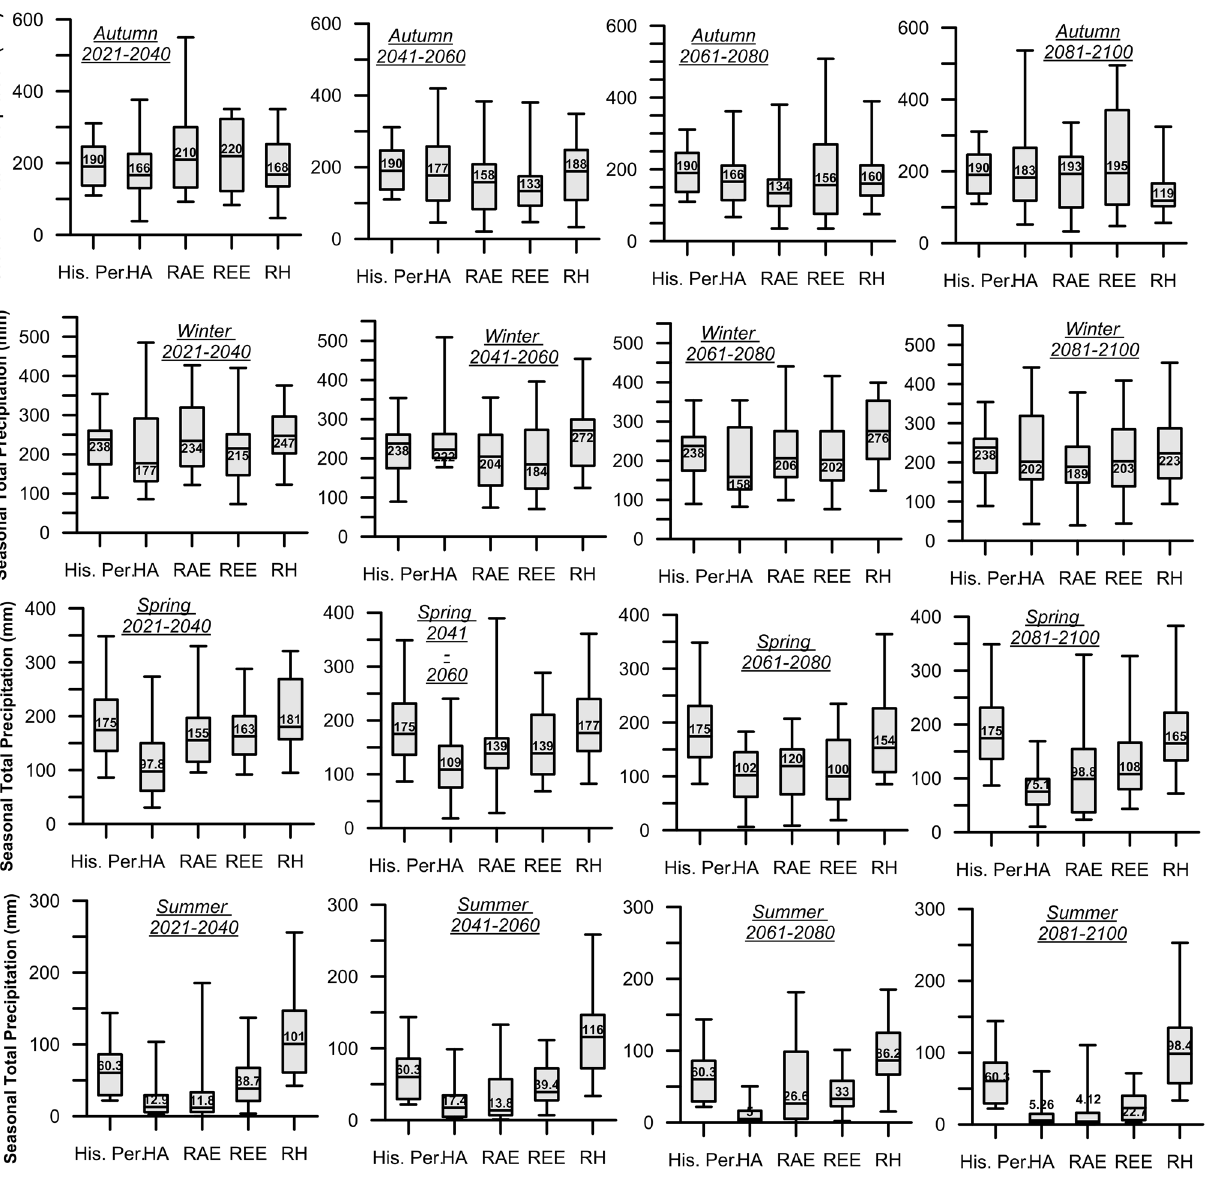
Fig. 5 Box-plots of seasonal total precipitation variation according to results from the four RCM–GCM combinations for the periods